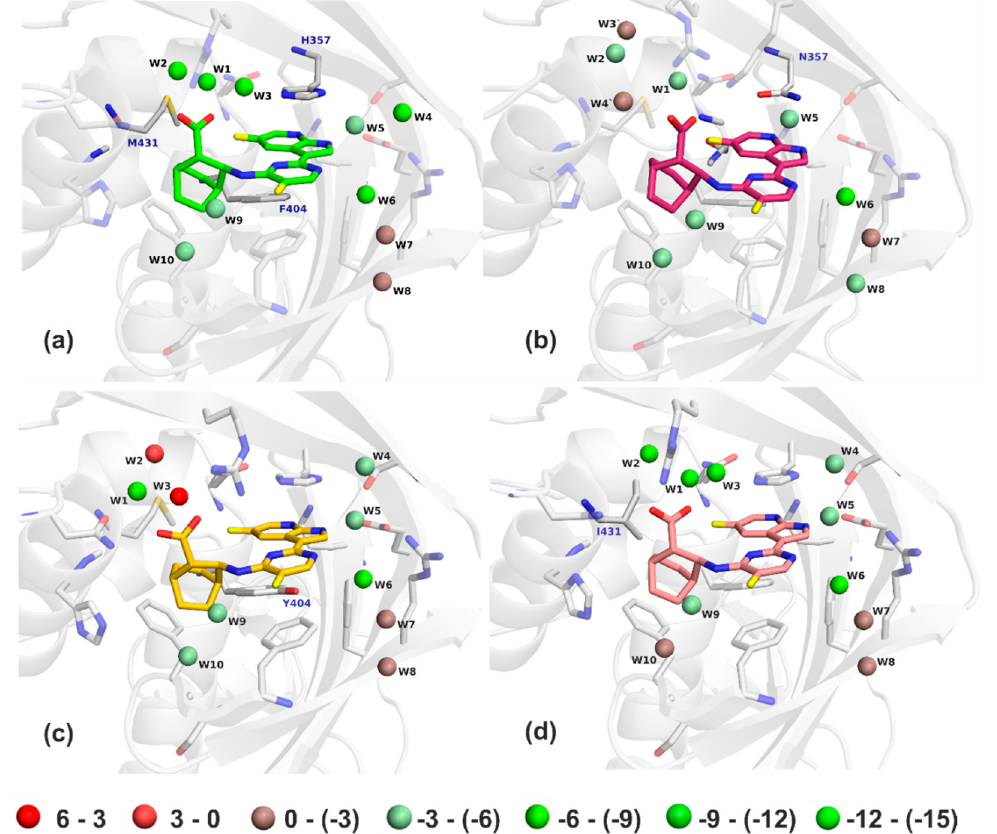
Figure 8. The PM6-D3H4X/COSMO2 “free” energies of bridging water molecules in the WT ( a ), H357N ( b ), F404Y ( c ), and M431I ( d ) structures. Water molecules are colored from red to green (unfavorable to favorable “free” energy, respectively). The energy scale is in kcal.mol − 1 .